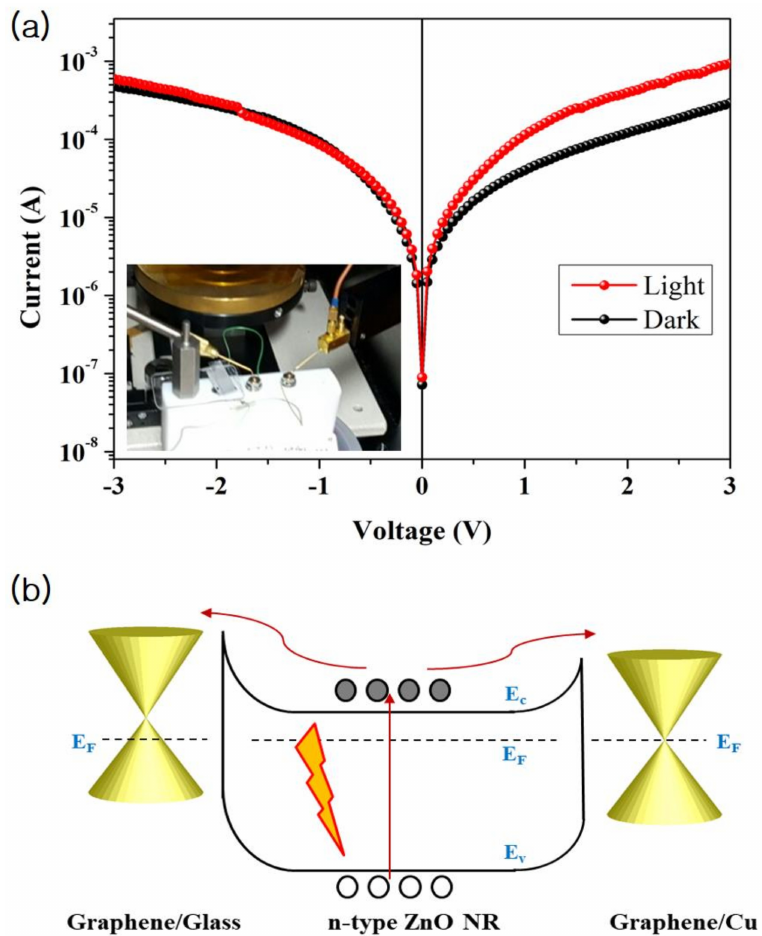
Figure 7. ( a ) I-V characteristics of the glass/graphene/ZnO NRs/graphene/Cu hybrid- heterostructure under dark and illuminated conditions. The inset of figure shows the photo image of an I-V measuring instrument; ( b ) Energy band diagram for the suggested nanostructure, where the white (black) circles represent holes